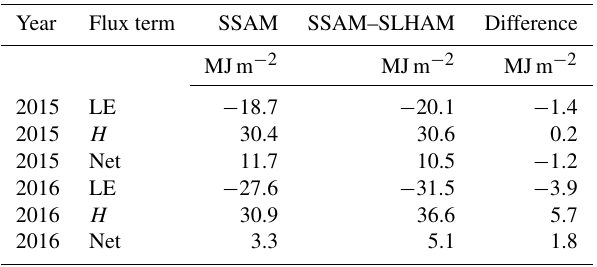
Table 6. Cumulative energy from sensible, latent and net exchange for 2015 and 2016 snowmelt simulations with (SSAM–SLHAM) and without (SSAM)